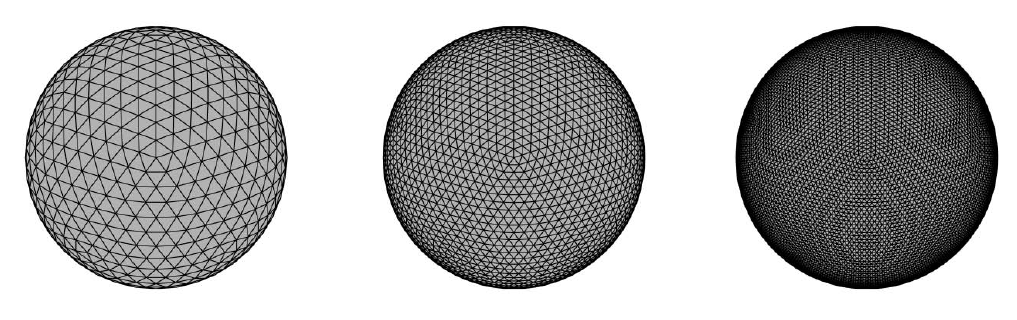
Figure 15. Four-fold DGGSs based on the icosahedron version of SACs (level = 3, 4,